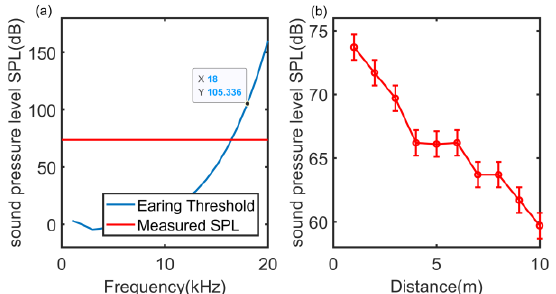
Figure 6. ( a ) The relationship between hearing threshold and frequency, where measured SPL represents the maximum SPL in LFM of 18 kHz – 23 kHz. ( b ) The SPL with distance.